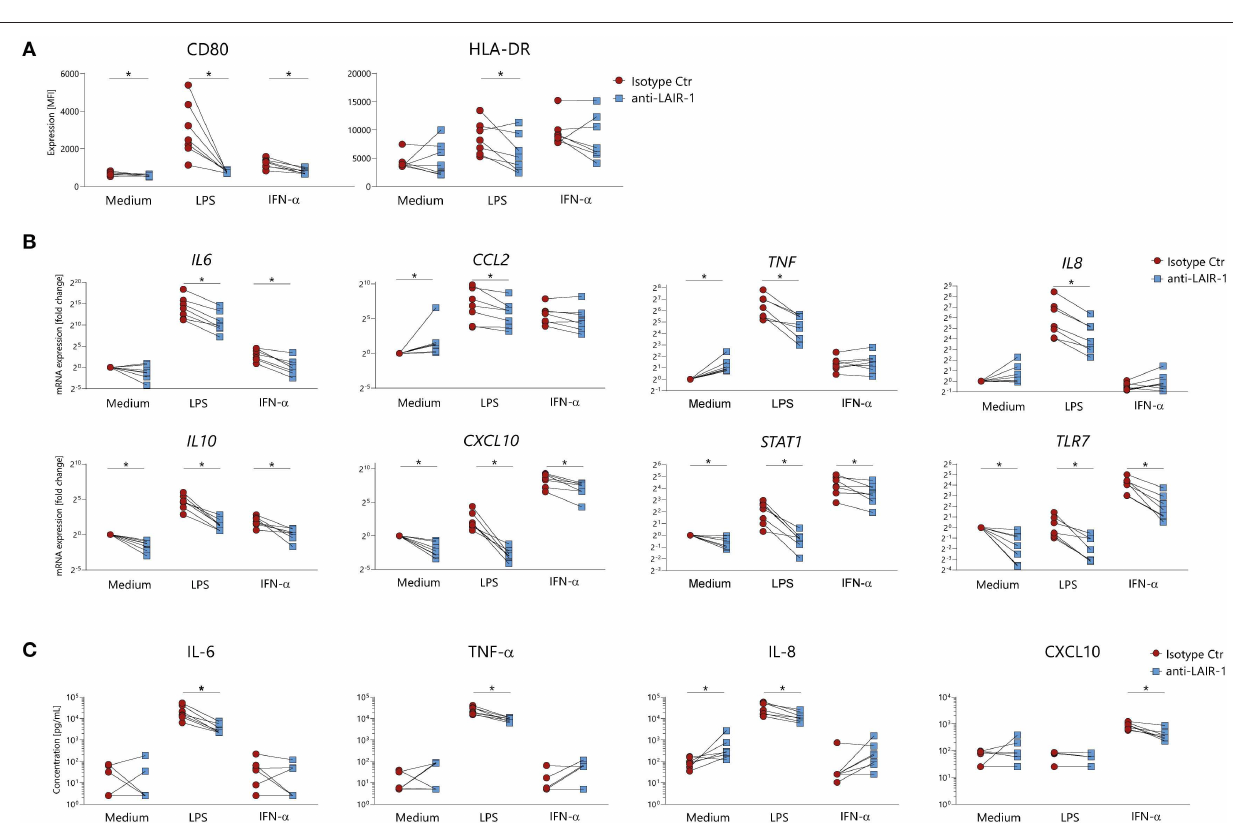
FIGURE 3 | LAIR-1 triggering modulates monocytes activation upon in vitro stimulation. (A) PBMCs were pre-treated with anti-LAIR-1 agonist (Dx26) or isotype control (2h) and stimulated overnight with TLR4 agonist- LPS or IFN- α and the expression of CD80 and HLA-DR was determined on gated monocytes, using flow cytometry. (B,C) MACS purified monocytes were pre-treated (2h) with anti-LAIR-1 agonist (Dx26) or isotype control and stimulated 5h with TLR4 agonist- LPS or IFN- α . (B) IL6 , CXCL10 , TNF , TLR7 , IL8 , IL10 , CCL2, and STAT1 gene expression was evaluated by qRT-PCR and (C) protein production of IL-6, TNF- α , IL-8, and CXCL10 was measured by ELISA. Results are represented as paired samples. Statistically significant differences were considered when * p < 0.05 (Wilcoxon’s